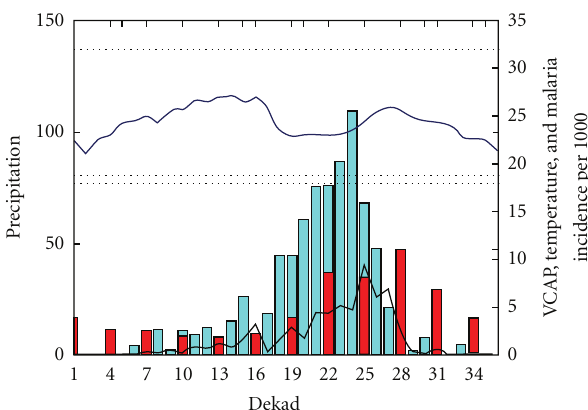
Figure 4: the black line represents the VCAP values (between 0 and 35), the blue bar represents rainfall (mm/dekad from 0 to 150 mm), the blue line represents temperature (between 18 ◦ C and 30 ◦ C), and the Red bar represents malaria incidence per 1000 habitants.